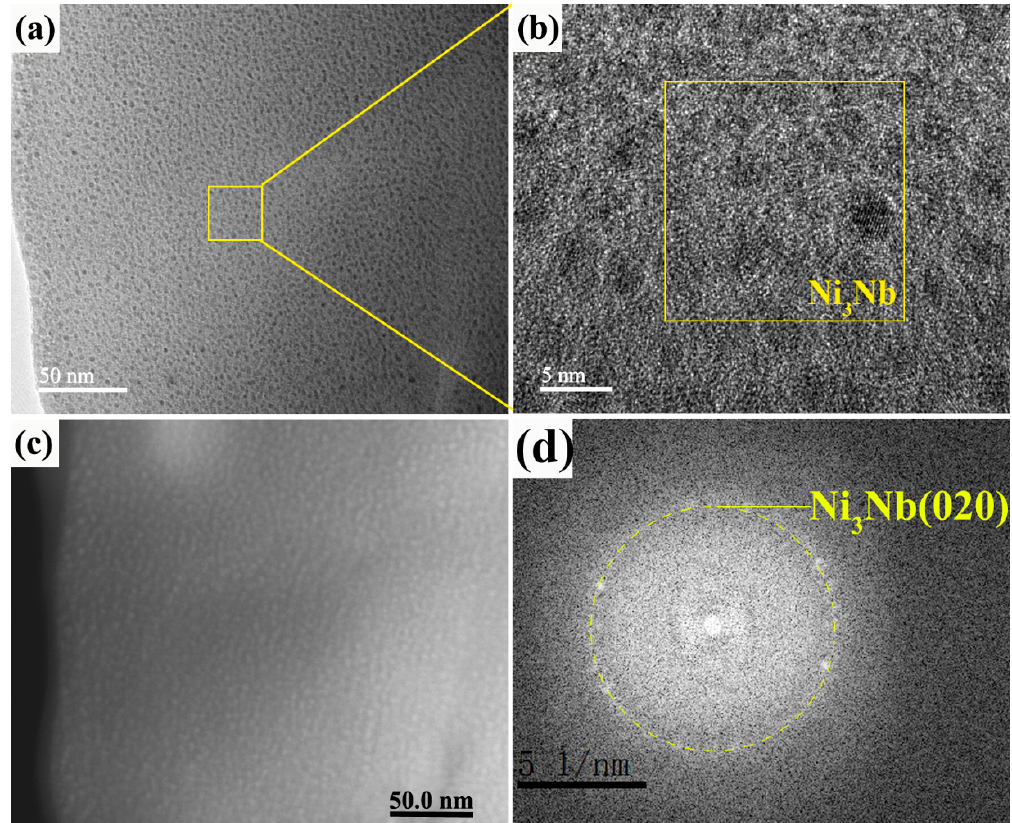
Figure 6. The TEM images, HADDF image and FFT pattern of the 20-pulsed Ni-Nb layer. ( a ) The amorphous phase; ( b ) The HRTEM image of local area in ( a ); ( c ) The HADDF image of amorphous matrix; ( d ) The corresponding SAED pattern of ( b ).